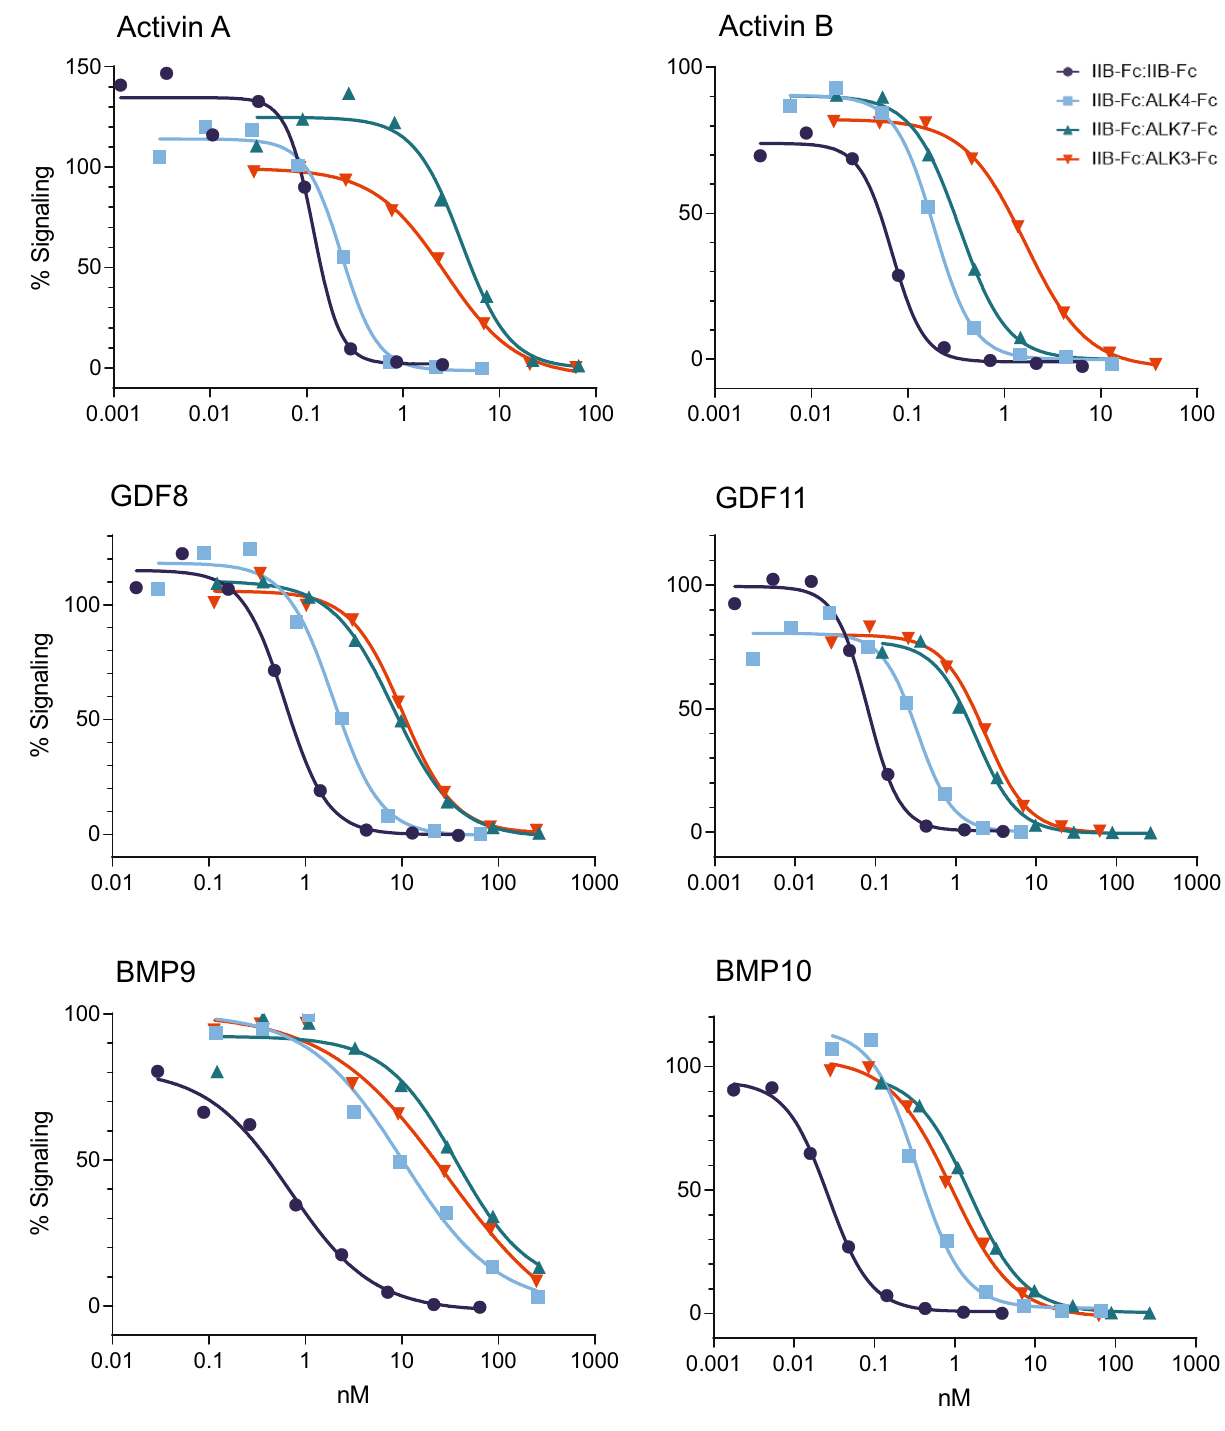
Figure 3. The type I receptor component in heterodimeric traps impacts signaling activity in a cellular context in vitro. Representative curves from assays conducted with a pSMAD2/3-responsive luciferase reporter gene in A204 cells (activin A, activin B, GDF8, and GDF11) or a pSMAD1/5/8-responsive luciferase reporter gene in T98G cells (BMP9 and BMP10) are depicted. Data from three independent experiments were used to determine mean values for half-maximal inhibitory concentration (IC 50 ) shown in Table 2. Signaling level of 100% was defined as reporter activity for cells treated with ligand alone and 0% as reporter activity for cells treated with media alone. Values above or below 100% at the lowest ligand trap concentrations therefore reflect experimental variability observed for this representative